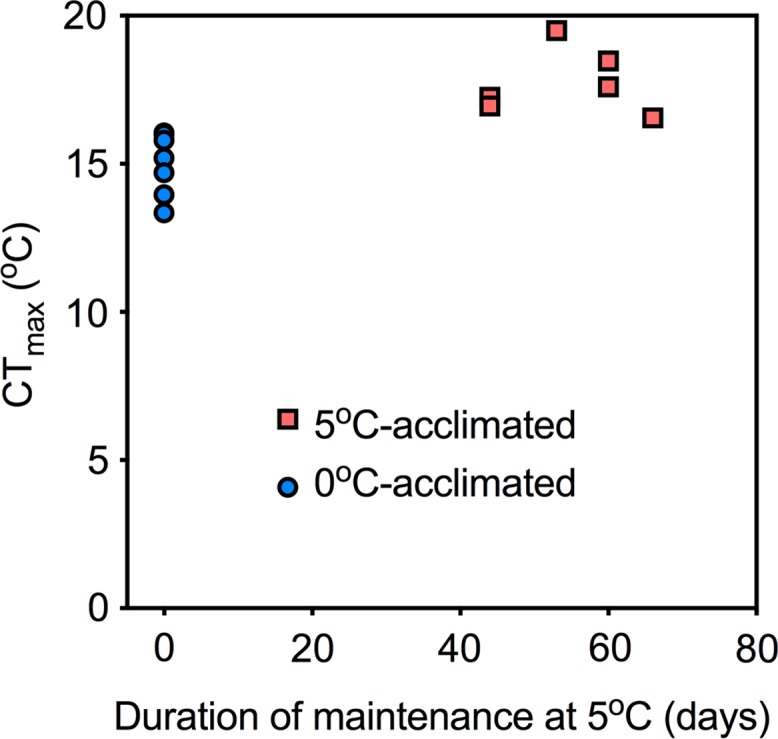
The relationship between acclimation duration and CTmax (defined as complete cardiac failure). As there was no significant effect of acclimation time on CTmax, data for the 5°C acclimation group were pooled, irrespective of acclimation duration